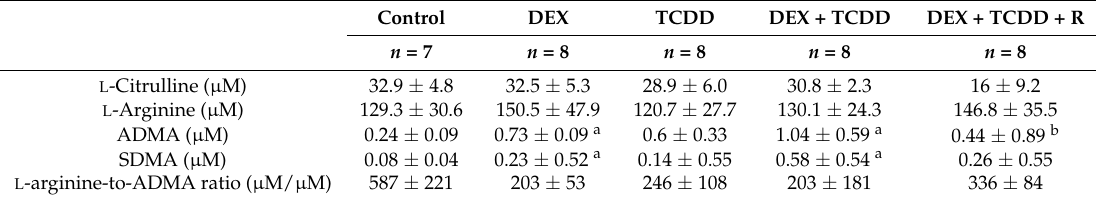
Table 2. Measures of Plasma L -Citrulline, L -Arginine, and Dimethylarginine Levels. Control DEX